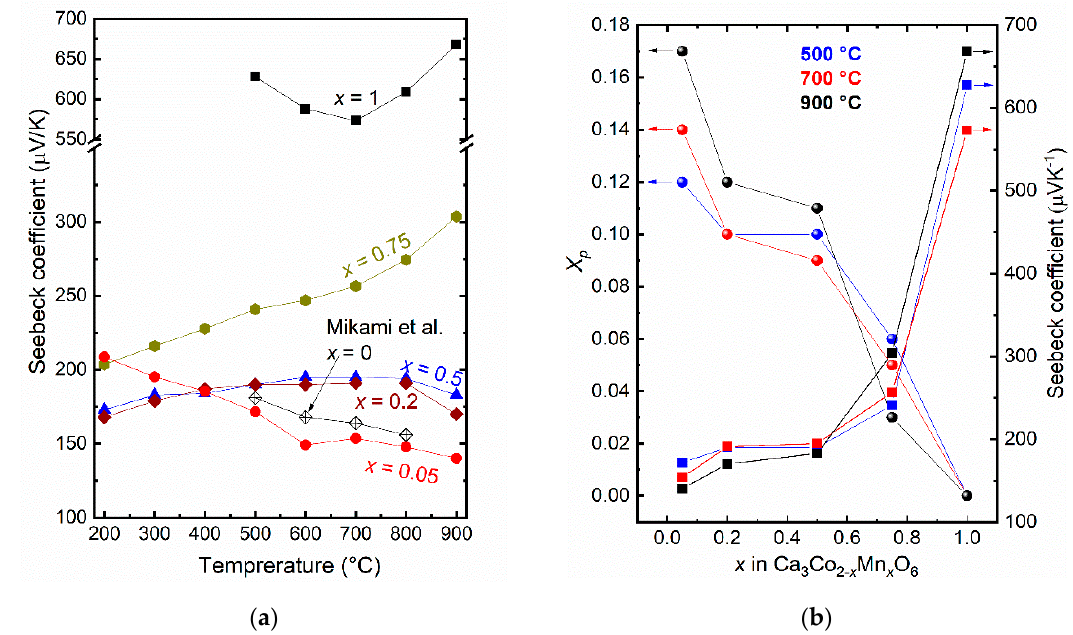
Figure 3. Seebeck coefficient of Ca 3 Co 2 − x Mn x O 6 as a function of ( a ) temperature and ( b ) x at selected temperatures. Data for Ca 3 Co 2 − x Mn x O 6 ( x = 0), from Mikami et al. [12], are included for comparison. Figure 3b includes a plot of X p (left hand axis) based on Equation (2), which is calculated from Seebeck coefficients at 500, 700, and 900 °C.